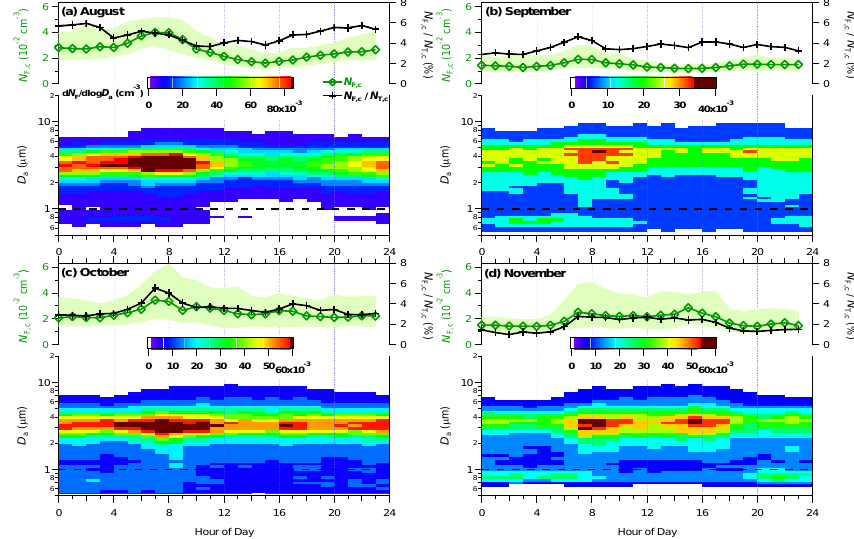
Fig. 3. Diel cycles of FBAP number concentrations and size distributions for each month of the measurement period (hourly median values vs. local time of day). Panel top halves: Integrated coarse FBAP concentration (1–20µm, N F , c ) on left axis (green) and FBAP fraction of TAP number ( N F , c / N T , c ) on right axis (black). Panel bottom halves: FBAP size distribution with hour of day on x-axis, aerodynamic diameter on y-axis and color scale of d N F /dlog D a with white values set to < 0.001cm − 3 for visual clarity. Dashed black line at 1.0µm shows particle size cut-off below which fluorescent particles were not considered FBAP due to interference with non-biological aerosol. Light-green shaded area shows FBAP concentration variability as the area between 25th–75th percentile traces. (a) August, (b) September, (c) October, and (d)